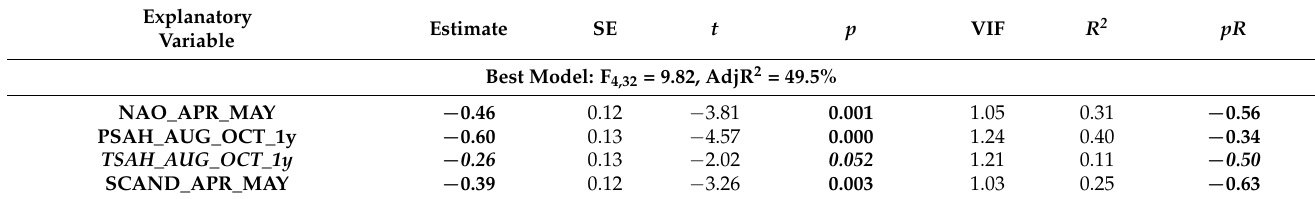
Table A12. Relationships between 15 climate variables and year and Annual Anomaly of the timing of spring migration for the Blackcap Sylvia atricapilla caught at Bukowo, Poland, in 1982–2021. Estimate—coefficients from multiple regression, SE—standard error of the estimates; t , p — t -test and significance of each estimate, p < 0.05 marked in bold face, 0.05 < p < 0.1 in bold italics . VIF—variance inflation factor. R 2 —partial determination coefficients, pR —Pearson’s partial correlation coefficient. Abbreviations of climate variables as in Table 1. pR visualised at Figure 5.